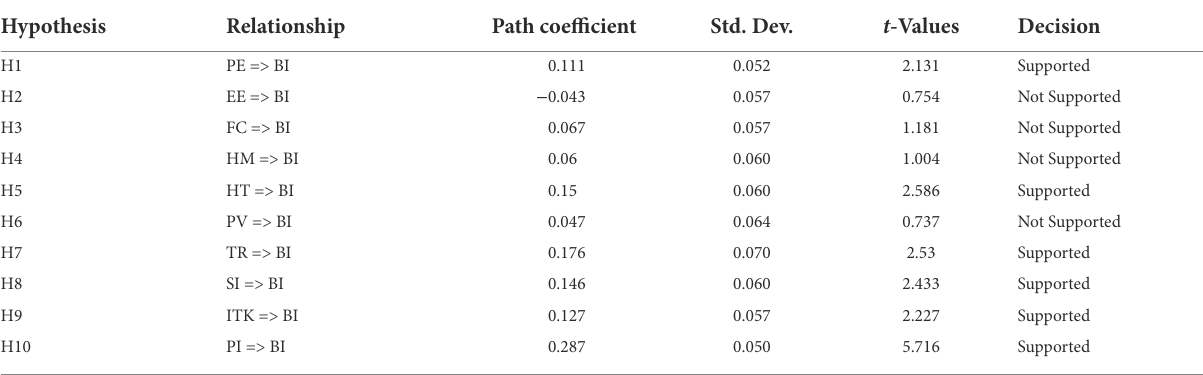
TABLE 5 Hypothesis